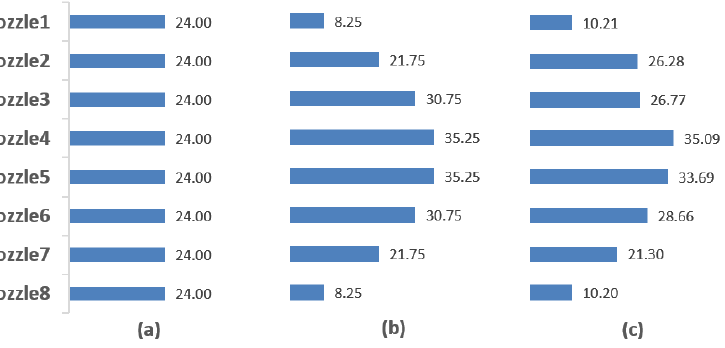
Figure 9. AIG nozzle flow-rate for the parabolic profile (unit, m/s). ( a ) Constant injection; ( b ) adjusted injection; ( c ) optimized injection. Table 2. Root mean square (RMS) of NH 3 /NO molar ratio at the inlet of the catalyst layer for the parabolic profile.